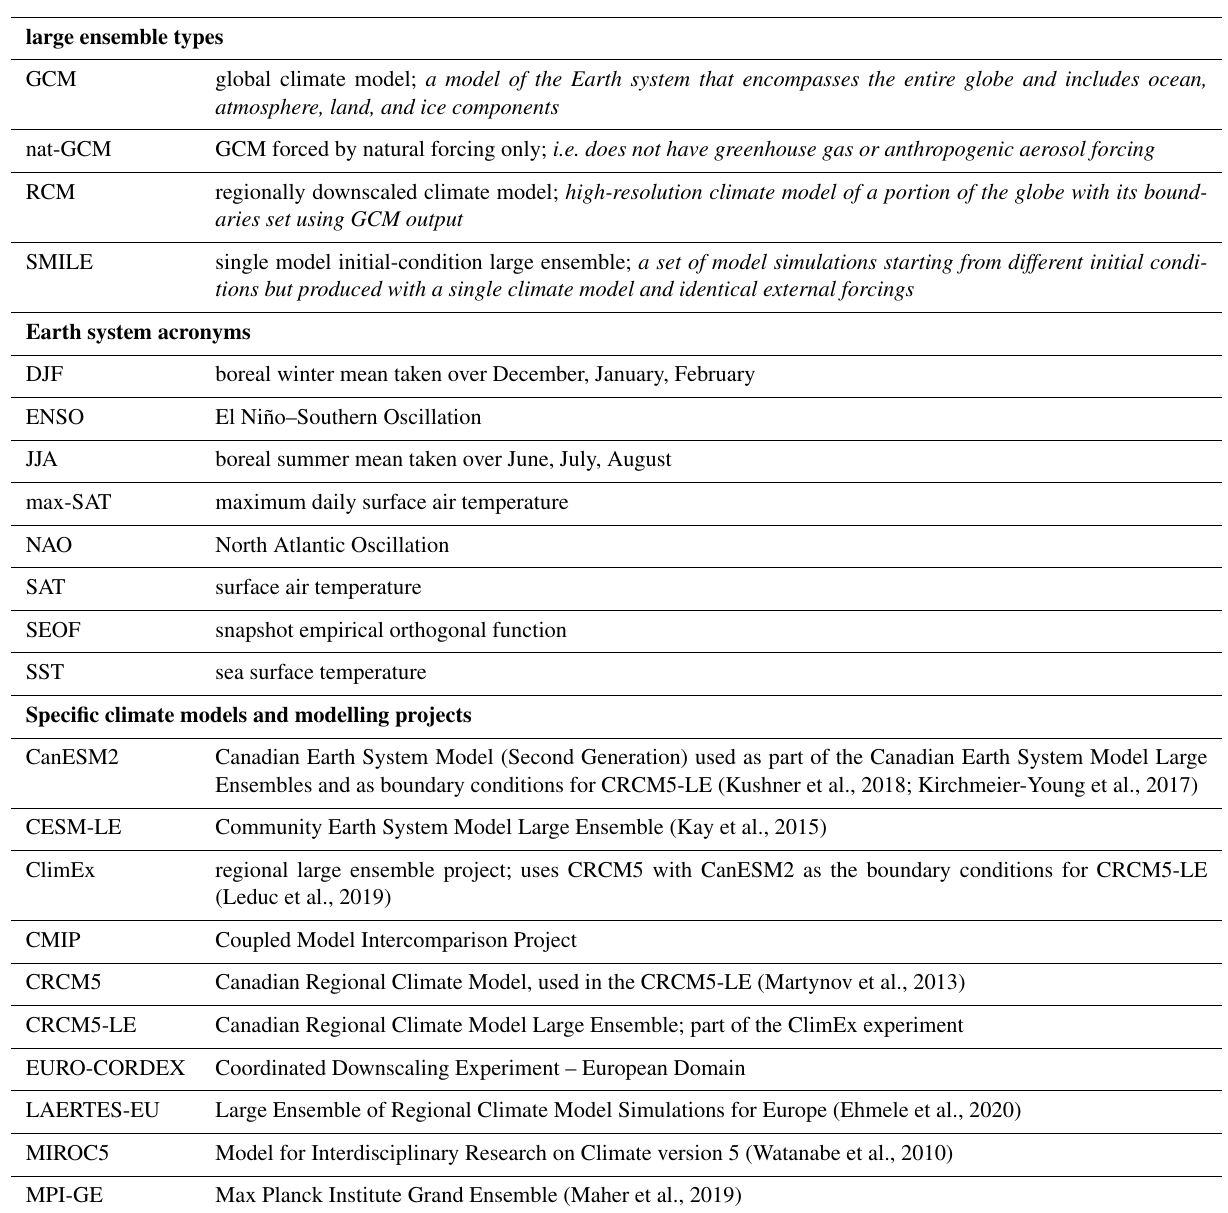
Table 1. Glossary of acronyms presented in alphabetical order for three categories: large ensemble types, Earth system acronyms, and specific climate models and modelling